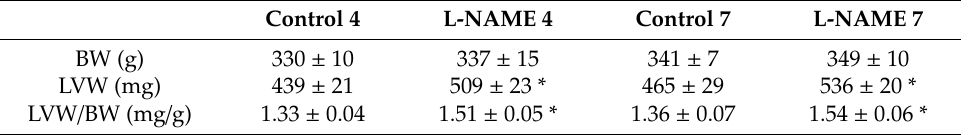
Figure 1. E ff ect of N G -nitro-L-arginine methyl ester (L-NAME) treatment on blood pressure (BP) increase. * p < 0.05 compared to age-matched controls. Table 1. Body weight (BW), left ventricle weight (LVW), and relative left ventricle (LVW / BW) of Wistar rats treated with L-NAME (40 mg / kg / day) for 4 and 7 weeks and age-matched